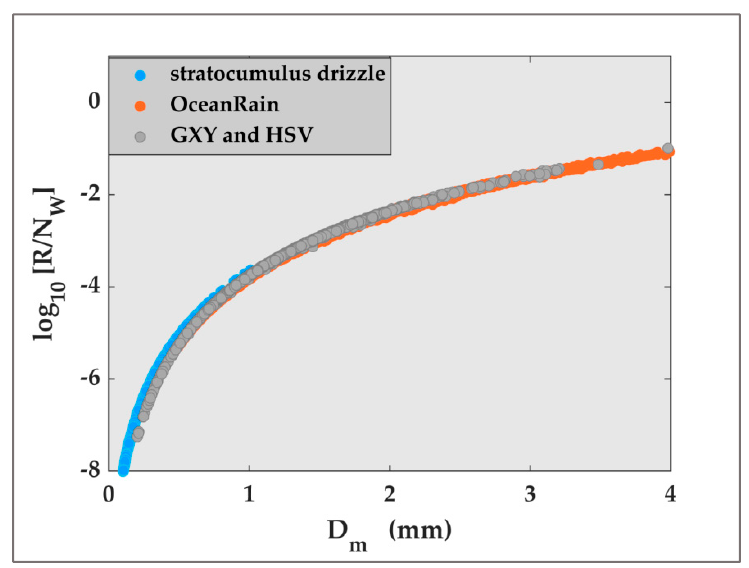
Figure 8. As in Figure 7, except DSDs from stratocumulus drizzle, OceanRain, and GXY-HSV.